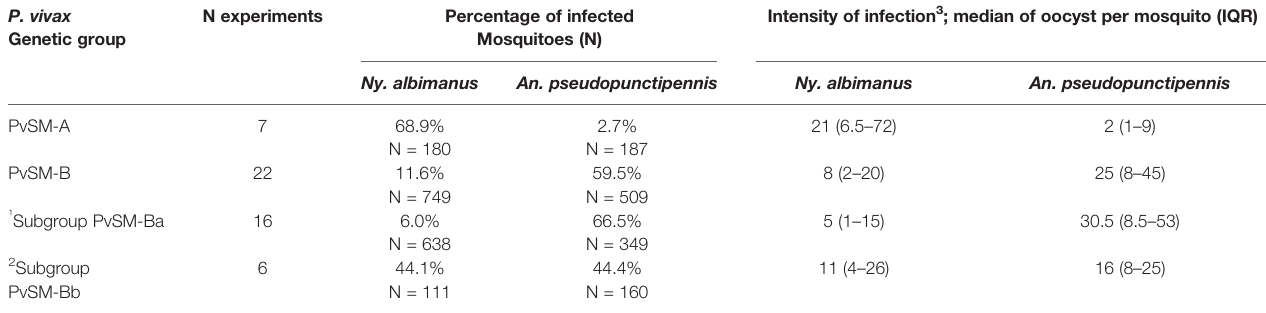
TABLE 4 | P. vivax lineages in southern Mexico: oocyst infection rate and intensity by mosquito species. P. vivax